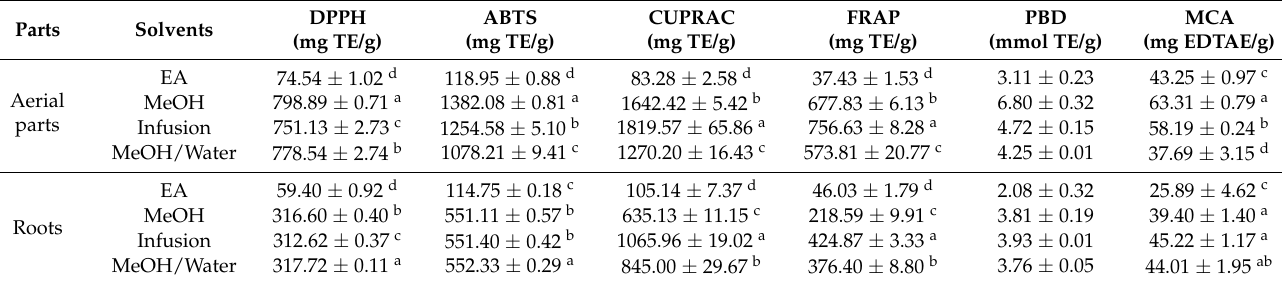
Table 5. Antioxidant properties of Epilobium hirsutum